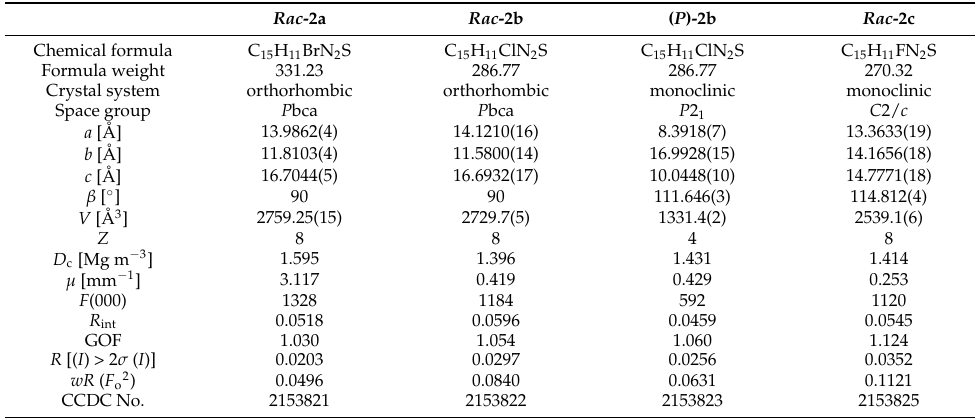
Table 3. Crystal data and structure refinement for 2